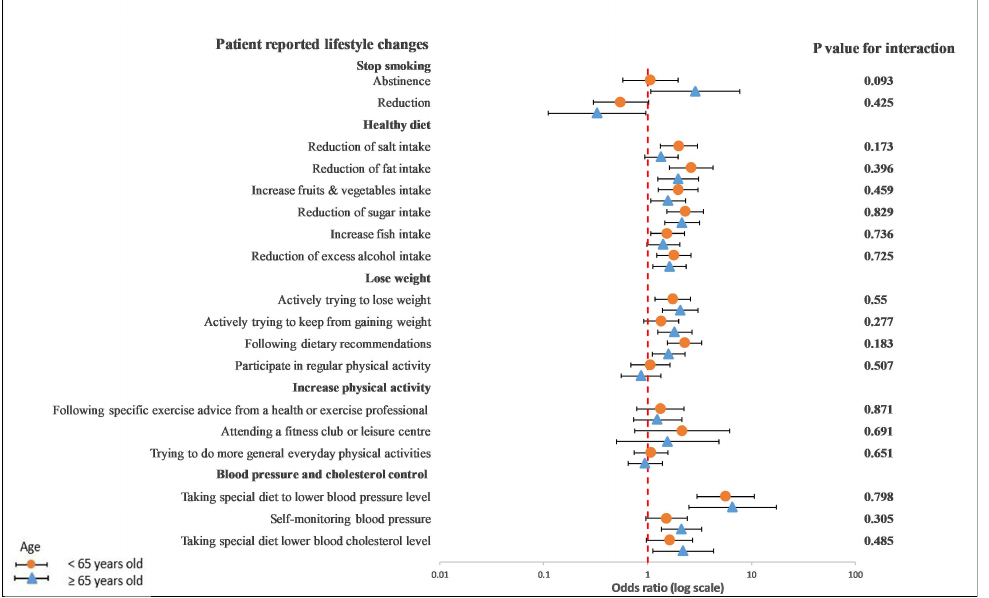
Figure 3. Univariable logistics regression analysis between the recollection of risk factors and patients’ reported lifestyle changes in younger and older patients. The p -value corresponds to the interaction between younger and older patients. The model included the recollection of risk factor information (PRRFI = 0 and GRRFI = 1) as the independent variable and patients’ reported lifestyle changes (no = 0 and yes = 1) as the dependent variables. PRRFI: poor recollection of risk factor information; GRRFI: good recollection of risk factor